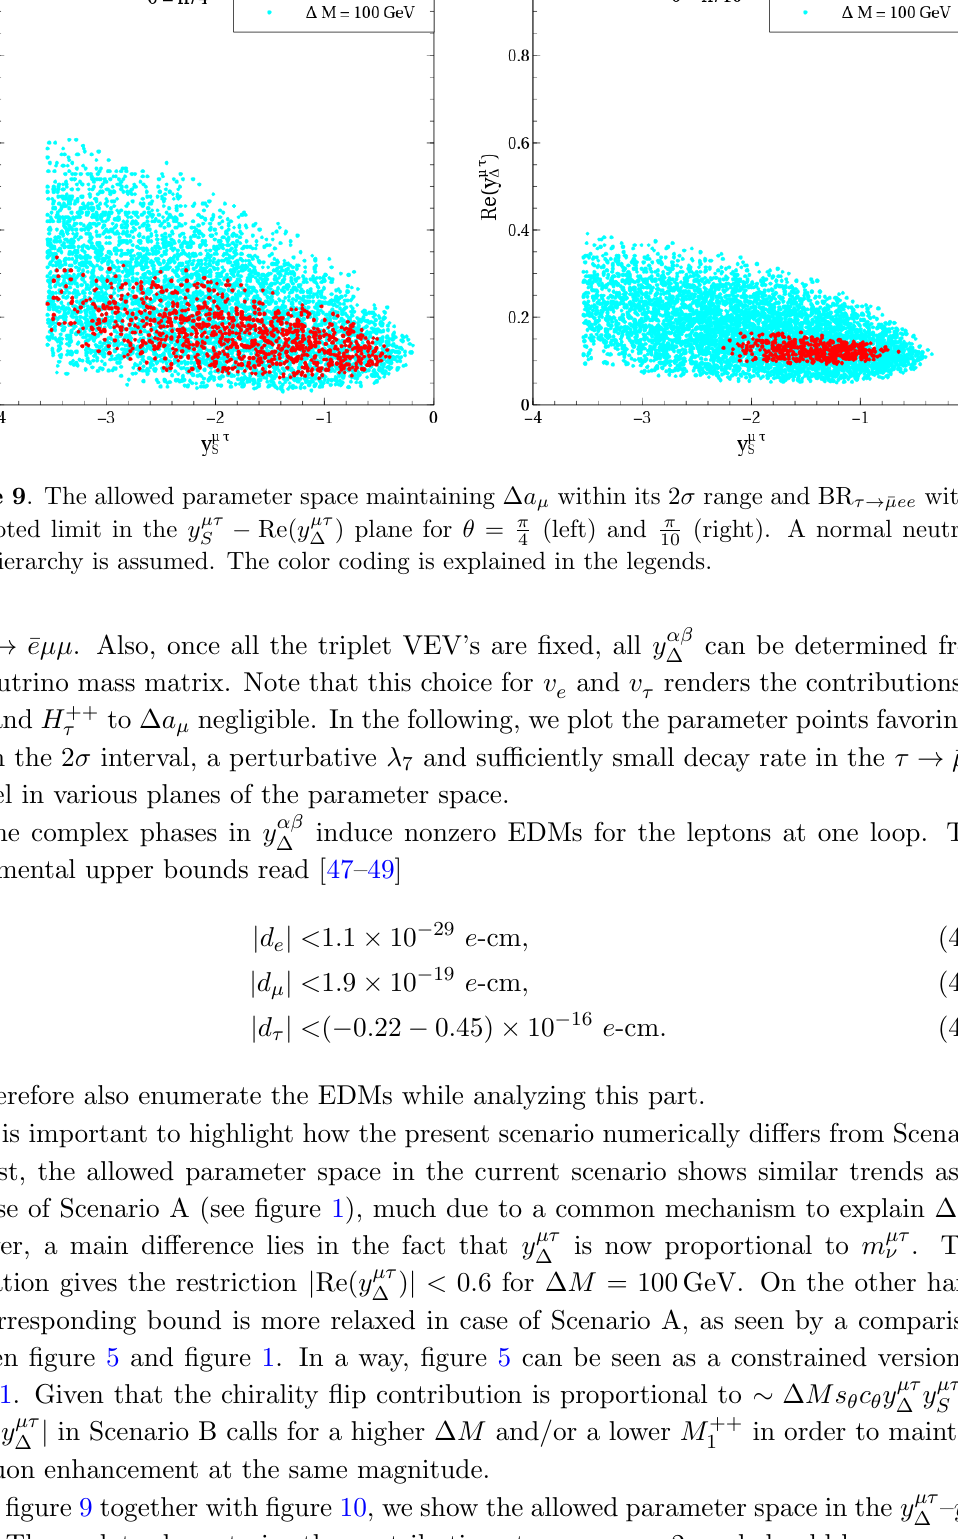
Re( y (cid:22)(cid:28) ) plane for (cid:18) = (cid:25) (left) and (cid:25) (right). A normal neutrino S (cid:0) (cid:1) 4 10